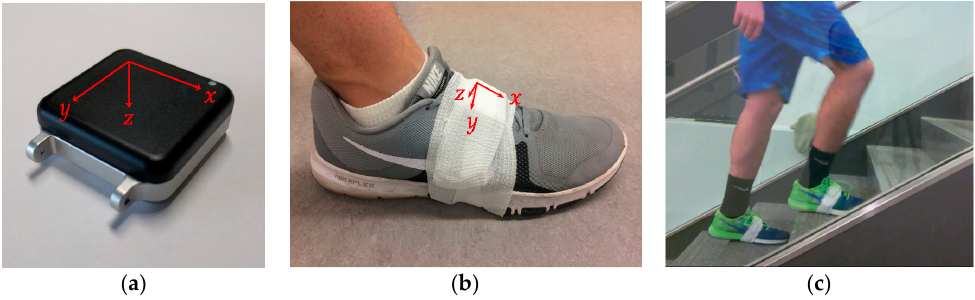
Figure 1. IMU data logger setup: ( a ) APDM IMU device showing the IMU sensor axes; ( b ) IMU attached to the shoe showing the IMU frame axes convention used in this paper; and ( c ) video stills showing the IMUs mounted on a subject's shoe climbing stairs ascent.